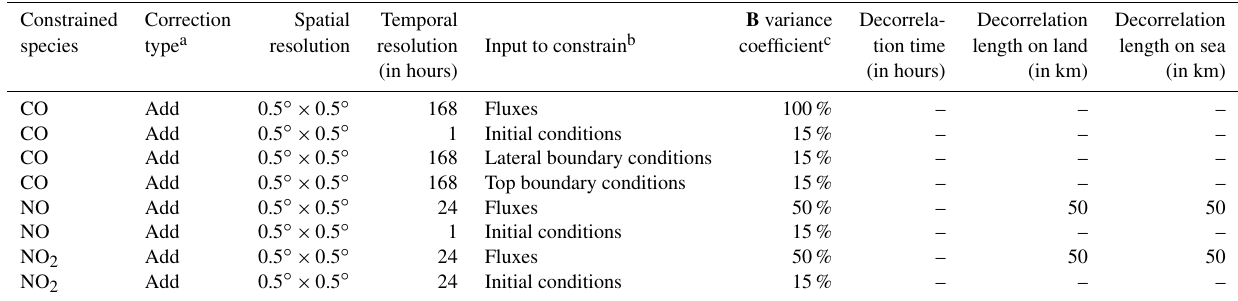
Table 1. Examples for the definition of the control vector and for the construction of the B matrix, as illustrated in Sect. 4. Constrained Correction Spatial Temporal